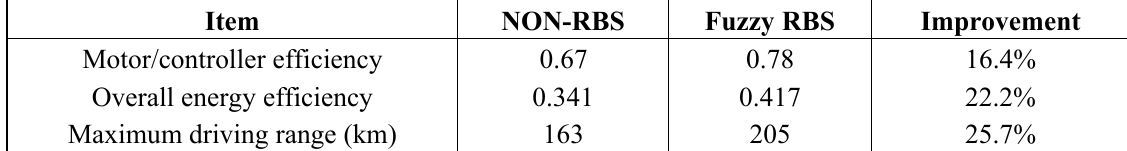
Table 4. Experimental